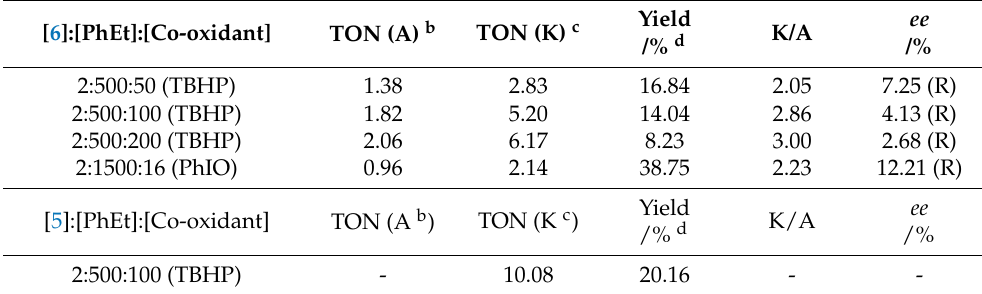
Figure 5. Dependence of the K/A ratio and the enantiomeric excess (ee%) on the oxidant concen- tration for the [Fe II (CDA-BPA*)] 2+ ( 6 ) catalysed oxidation of ethylbenzene with TBHP in CH 3 CN at 0 ◦ C. Table 3. Catalytic oxidation of ethylbenzene carried out by ( R,R )-( − )- 6 and ( R,R )-( − )- 5 with various co-oxidants a